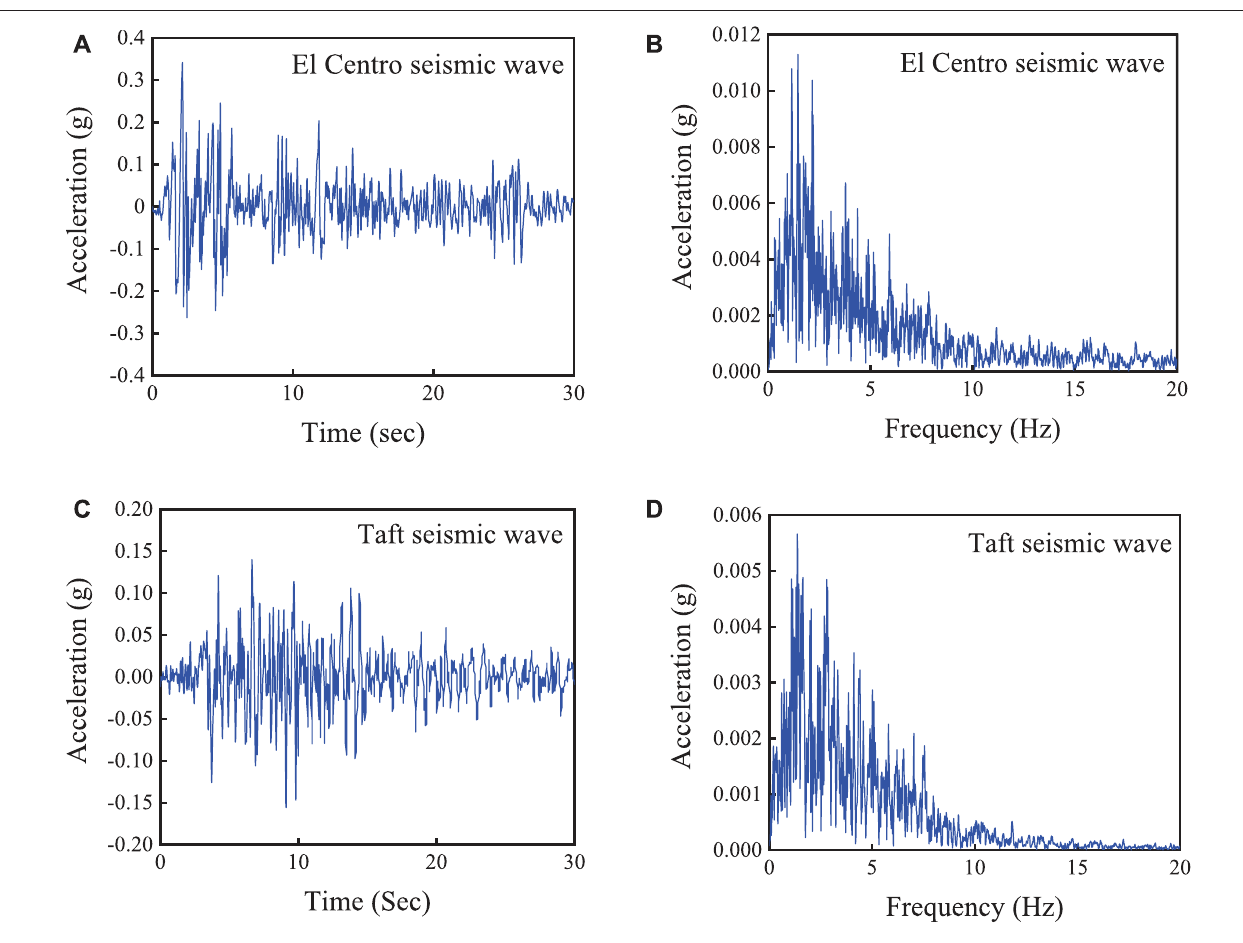
FIGURE 13 | Seismic excitation signal: (A) time evolution of El Centro seismic signal; (B) frequency content of El Centro seismic wave signal; (C) time evolution of Taft seismic wave signal; (D) frequency content of Taft seismic wave signal.